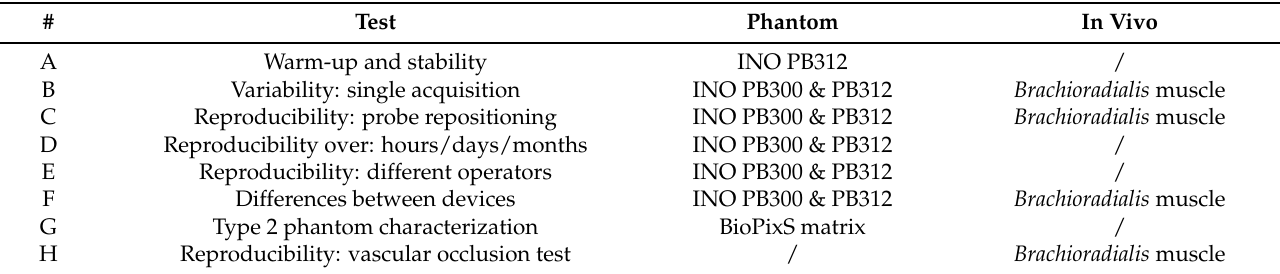
Table 1. Summary of reported tests. See text for